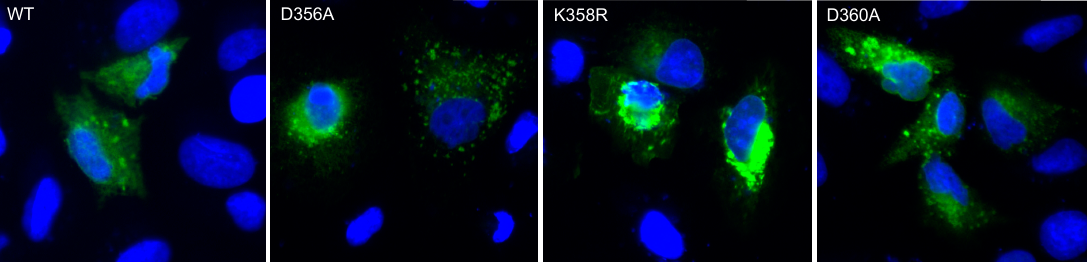
Figure 4. Intracellular expression of VP mutants. A549 cells were transfected at 18 h with plasmids expressing rVP wt , rVP-D356A, rVP-K358R, or rVP-D360A. Permeabilized cells were stained with anti-FLAG tag antibody (green) as the primary antibody. The nuclei were stained with DAPI (Blue). Immunostained cells were visualized with a fluorescent microscope. The same magnification of ×200 was used throughout.